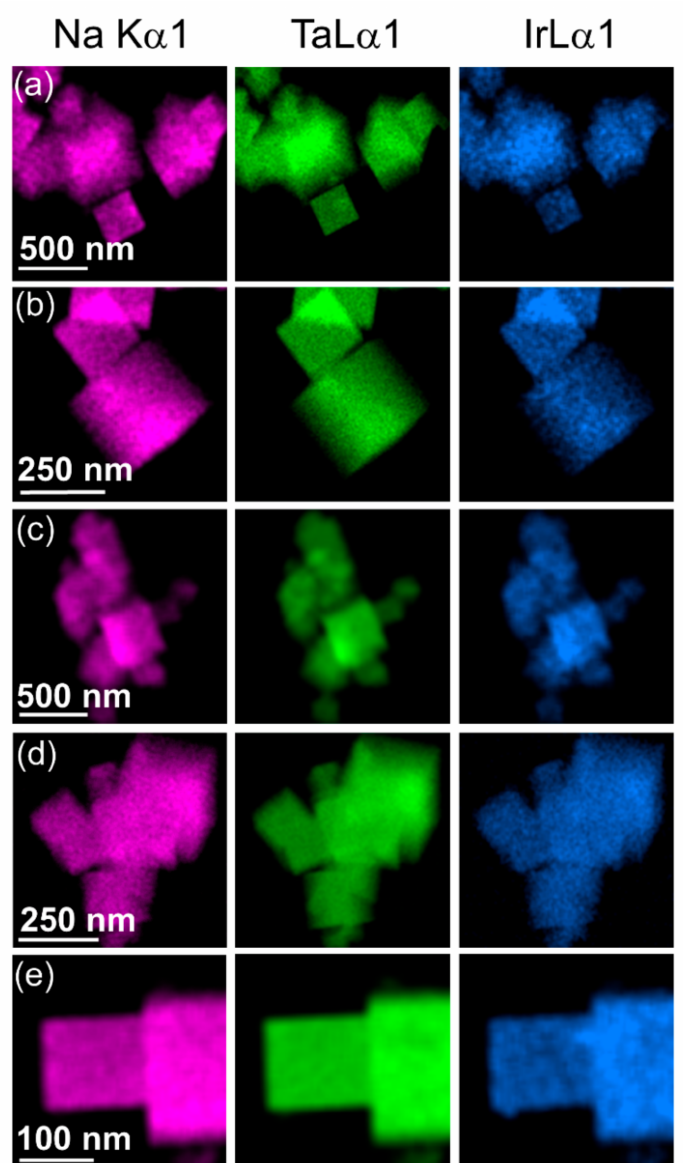
Figure 4. EDS maps performed using TEM of Ir-substituted NaTaO 3 materials with intended Ir